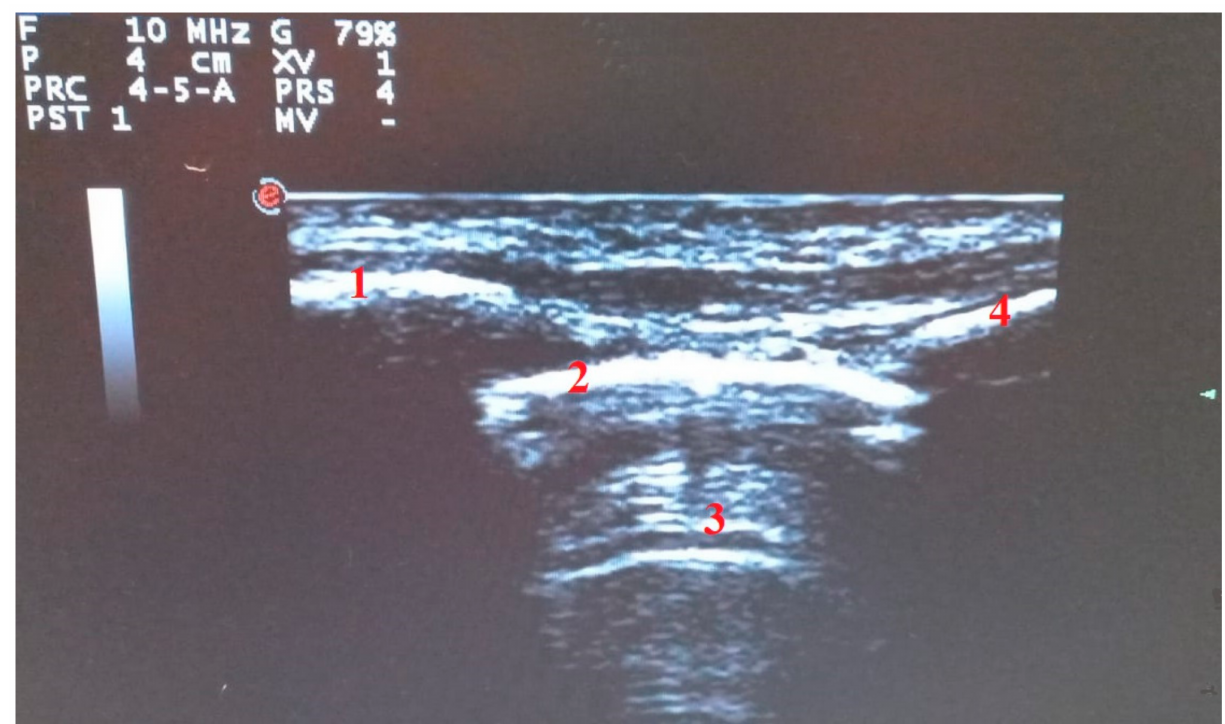
Figure 1. Longitudinal scan with linear probe: “the bat sign”. (1) Upper rib. (2) Pleural line. (3) A Lines. (4) Lower rib. It is possible to choose any transducer: cardiac, convex, micro convex or linear.